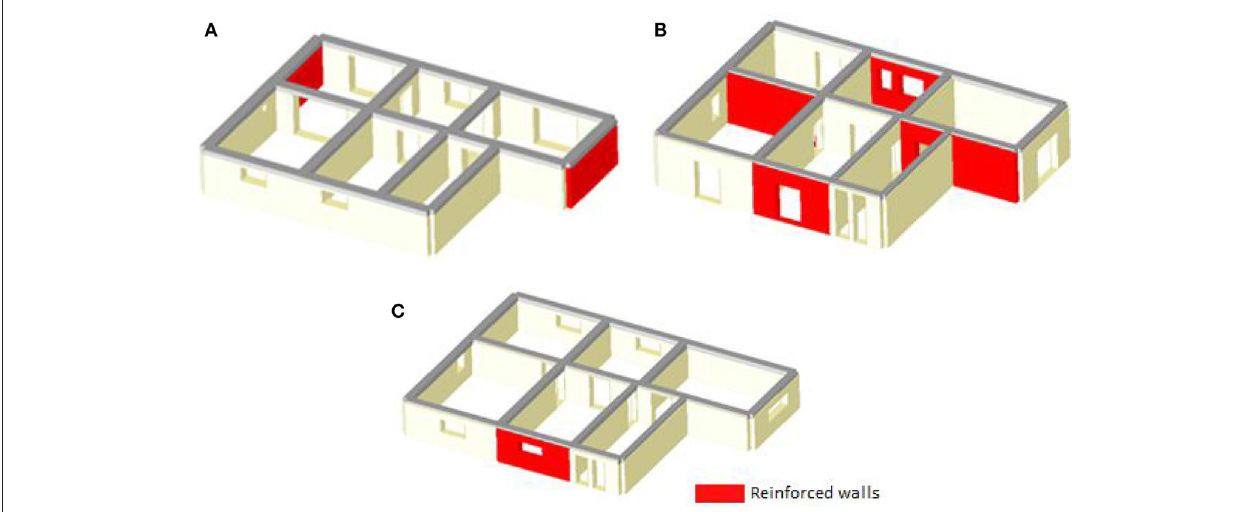
FIGURE 6 | Seismic upgrading interventions by reinforced plaster on first level (A) , second level (B) and third level (C) masonry walls.